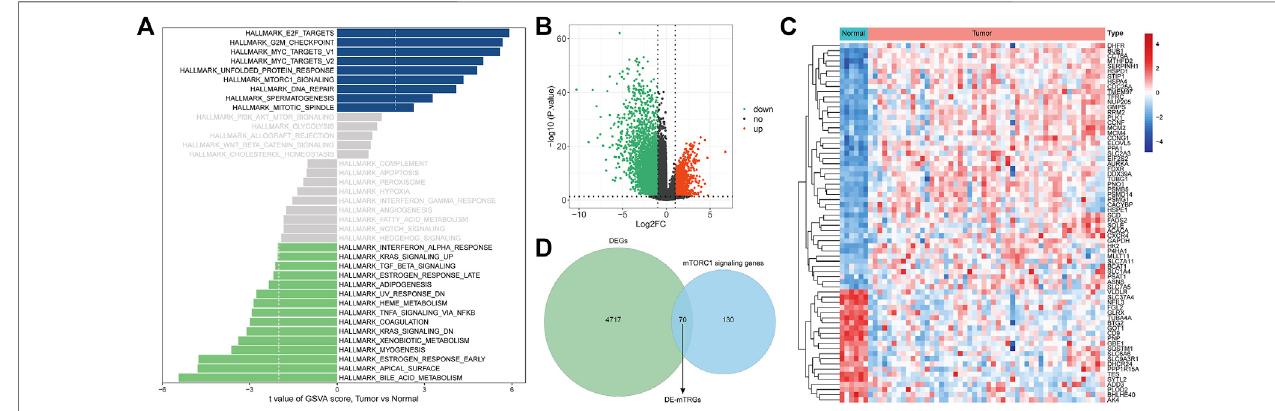
FIGURE 1 | Identi fi cation of differentially expressed mTORC1 pathway-related genes (DE-mTRGs) in MRTK. (A) GSVA analysis; (B) volcano map. Green: downregulated (Down), red: upregulated (Up), black: unchanged (no); (C) Heatmap of DE-mTRGs in MRTK; (D) Venn diagram. Green: differentially expressed genes; blue: mTORC1 signaling genes;intersecting section: